Question: State the chart type depicted above.
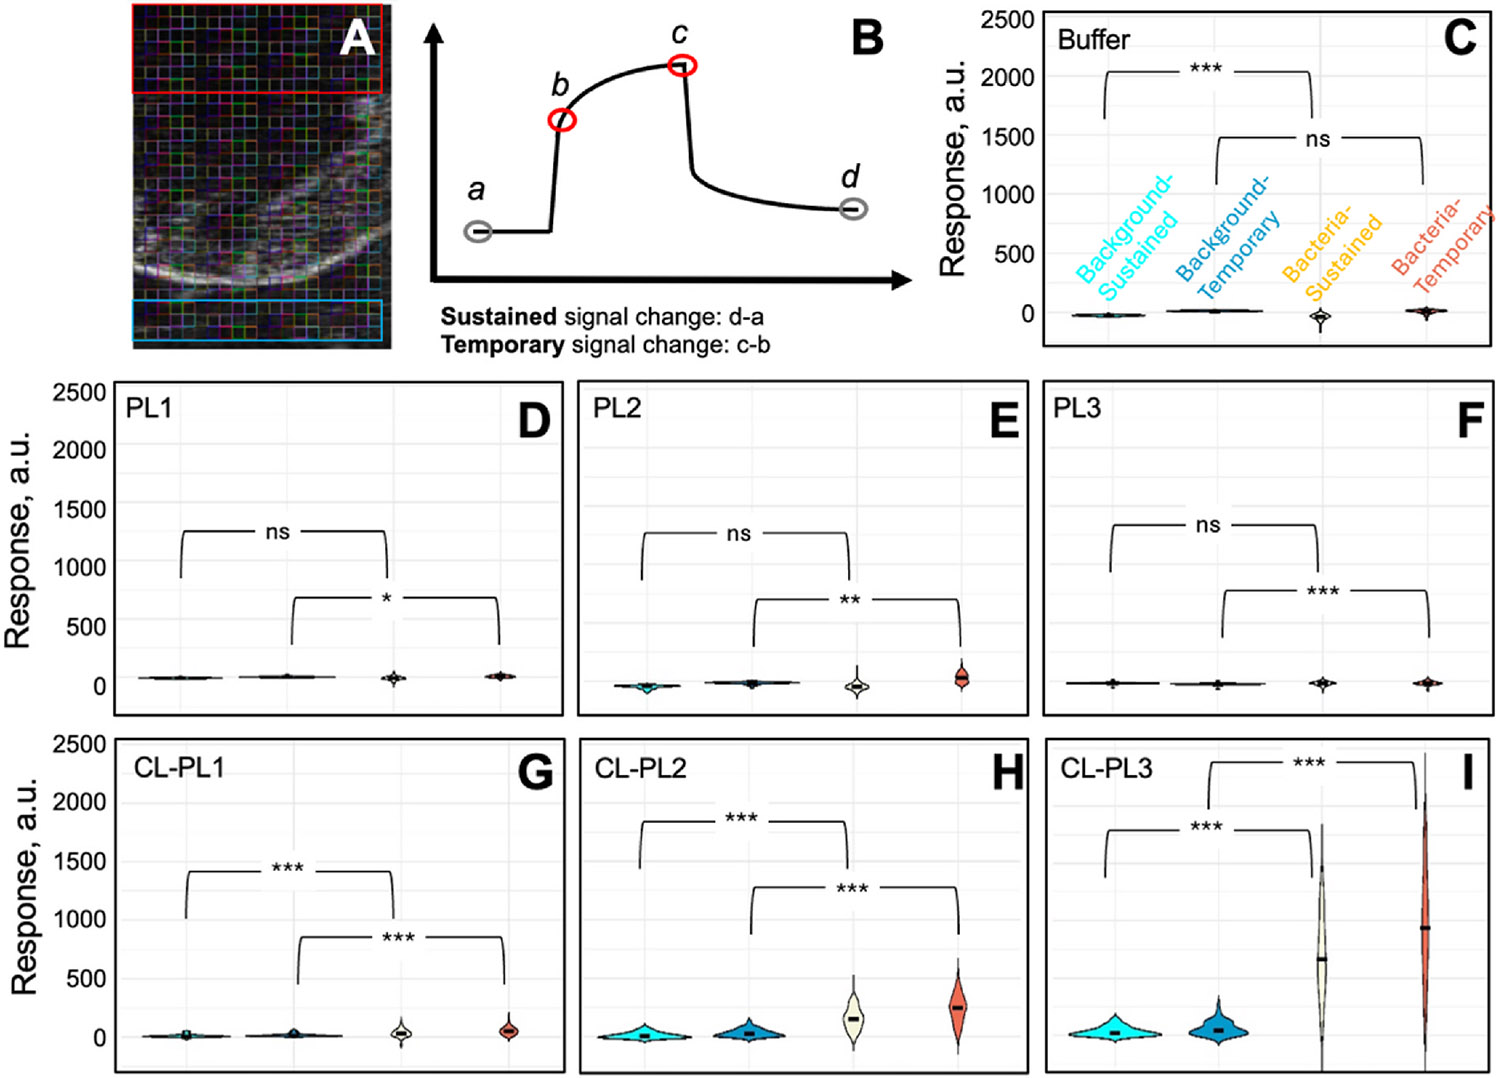
Answer: box